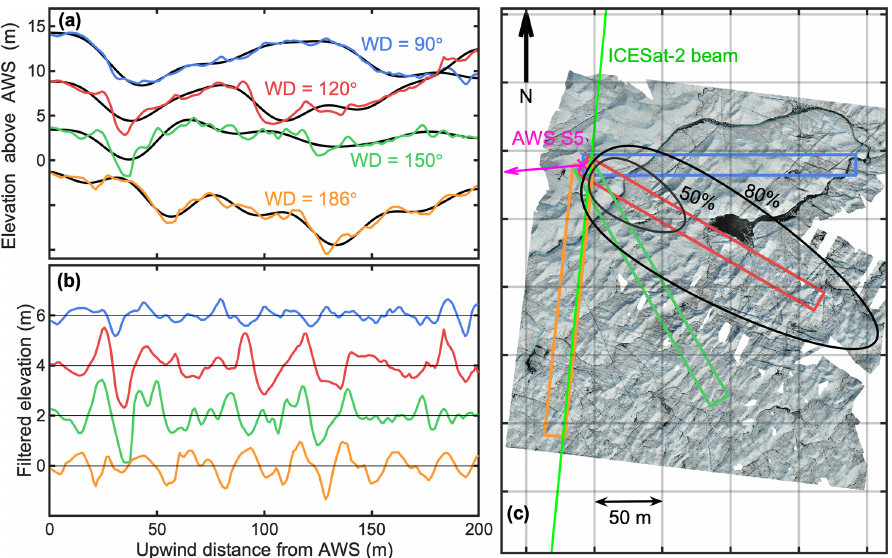
Figure 2. (a) Measured elevation profiles for four different wind directions upwind of AWS S5. (b) Filtered elevation profiles and (c) or- thomosaic true-colour image of AWS S5 and surroundings taken by UAV photogrammetry on 6 September 2019. The different coloured rectangles in (c) indicate the profiles shown in panel (a) . The profiles have been vertically offset by 5m in (a) and by 2m in (b) for clarity. The black line in (a) denotes the low-frequency contribution of the profiles for a cut-off wavelength (cid:51) = 35m. The pink arrow in (c) denotes the displacement vector of the AWS between the ICESat-2 overpass on 14 March 2019 and the UAV imagery on 6 September 2019. The estimated extent of the 50% and 80% fetch footprints for the data in September 2019 in a specific wind direction is shown by the black ovals.